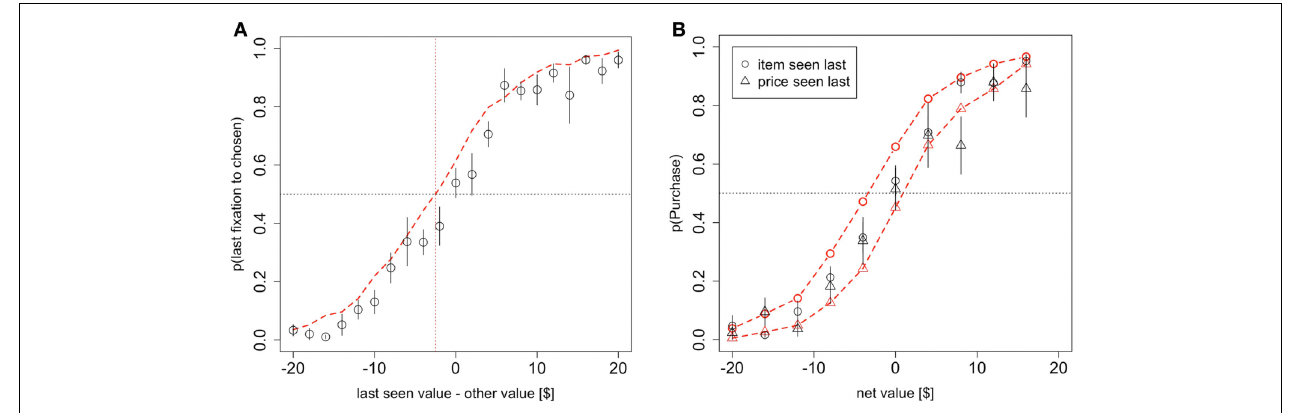
contingent on whether the last fixation was to the product or to the price. Black circles indicate data from the odd-numbered trials of the subject data, and red dashed lines indicate the simulated data from the aDDM. Bars are standard error bars, clustered by